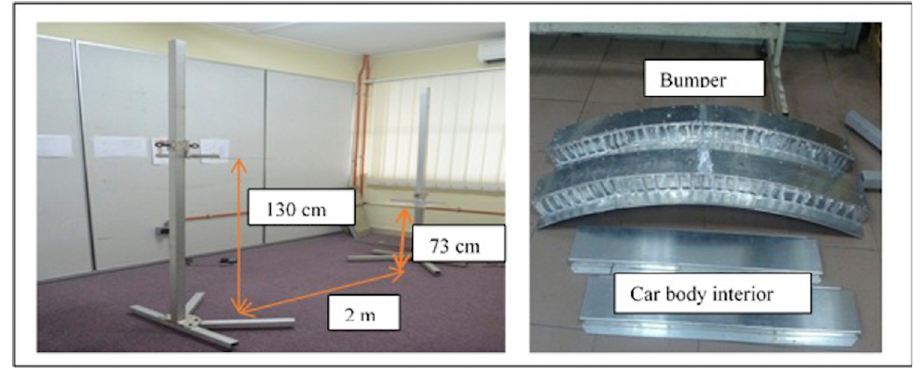
Fig 1. Experimental set